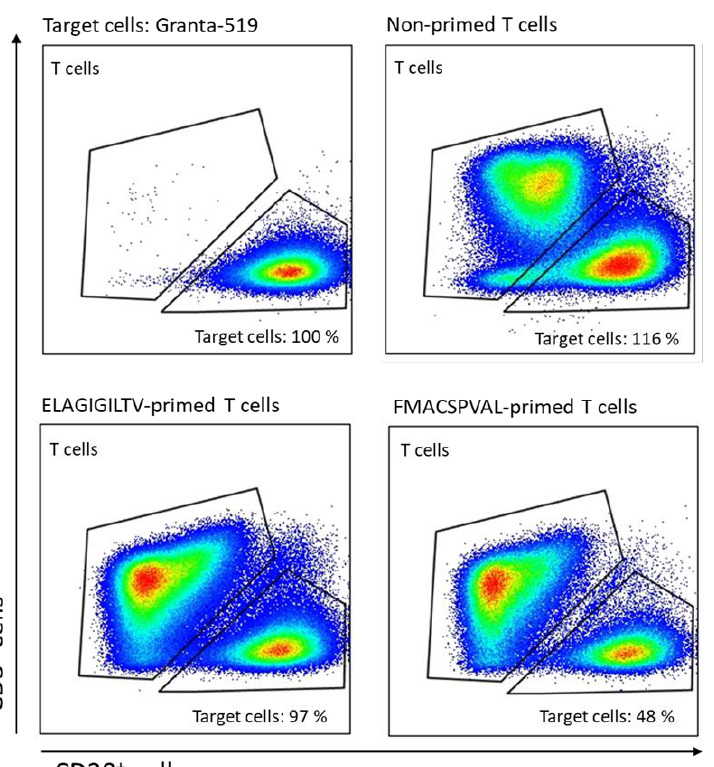
Figure 8. Cytotoxic capability of SOX11-specific T cells. FMACSPVAL-primed T cells were able to kill 52% of target SOX11-expressing cells. Non-primed T cells served as a negative control. Target cells were co-cultured with T cells for 24 h before staining and detection via flow cytometry .